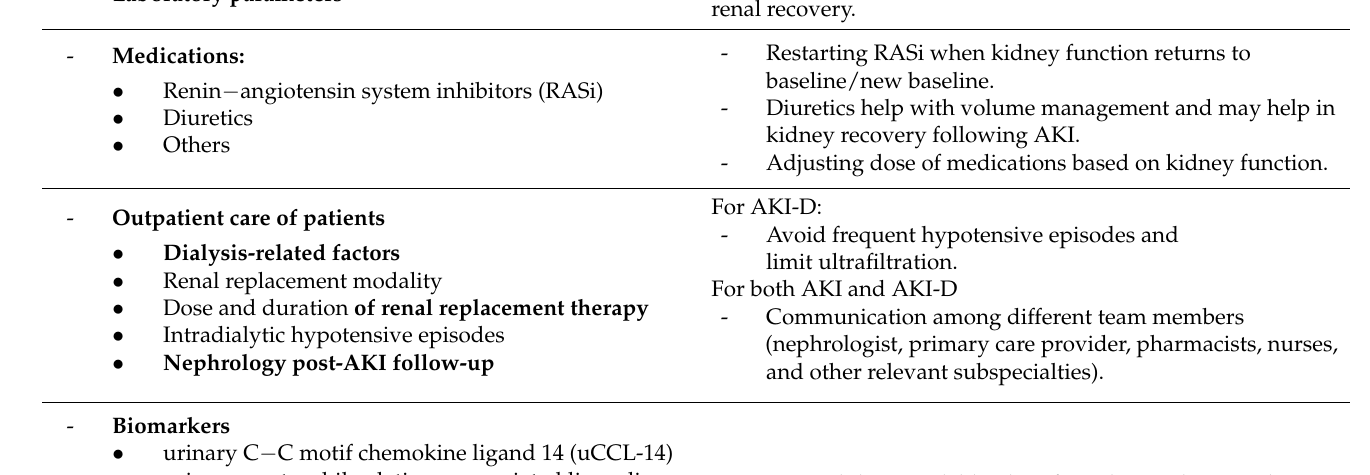
- Limited data available identifying biomarkers predicting further AKI